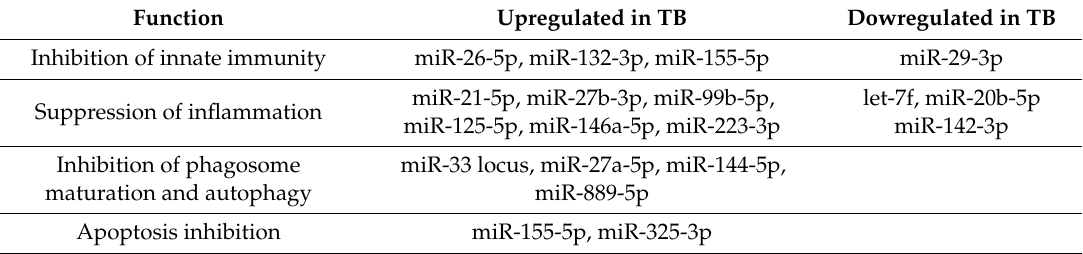
Table 1. Summary of the role of microRNAs (miRNAs) in tuberculosis (TB)